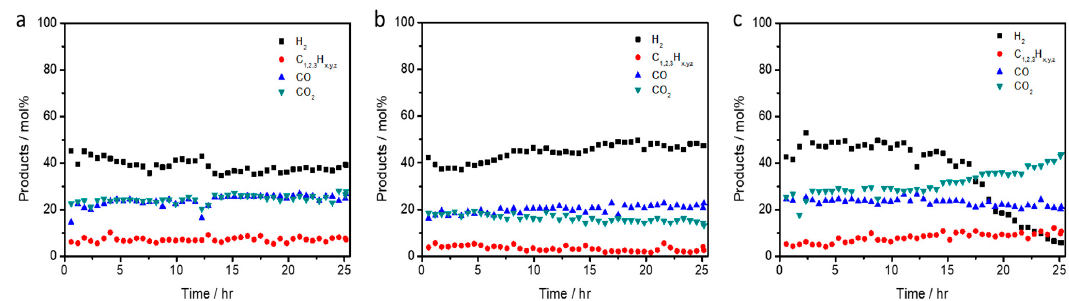
Figure 6. Products distribution (mol %) of the reformate (H 2 , CO, CO 2 , and C 1,2,3 H n ) during long-term LCO-ATR reaction (25 h) for ( a ) LaCo 0.85 Ru 0.15 O 3 , ( b ) LaCr 0.85 Ru 0.15 O 3 and ( c ) Pt-GDC reference catalysts (H 2 O / O 2 / C = 1.5 / 0.4 / 1, 1127 K, GHSV = 4000 h − 1 ).